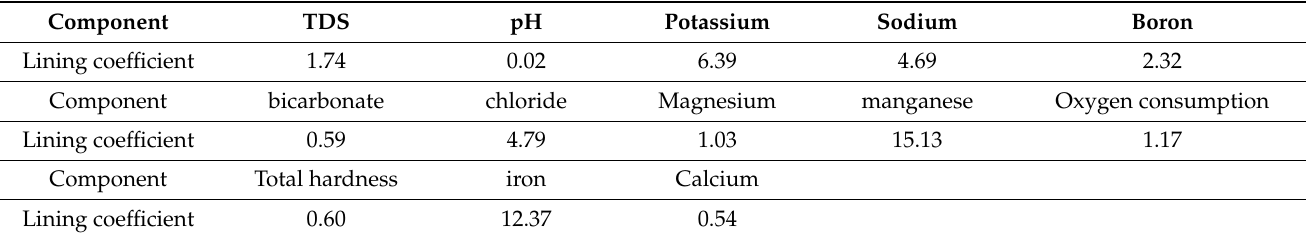
Table 2. Variance table of groundwater chemical composition contrast